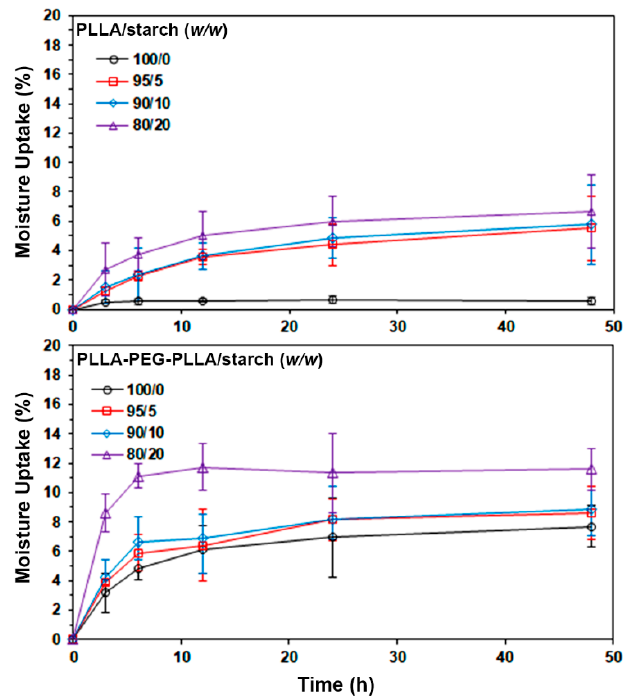
Figure 10. Moisture uptake of ( above ) PLLA/starch and ( below ) PLLA-PEG-PLLA/starch films with various blend ratios.